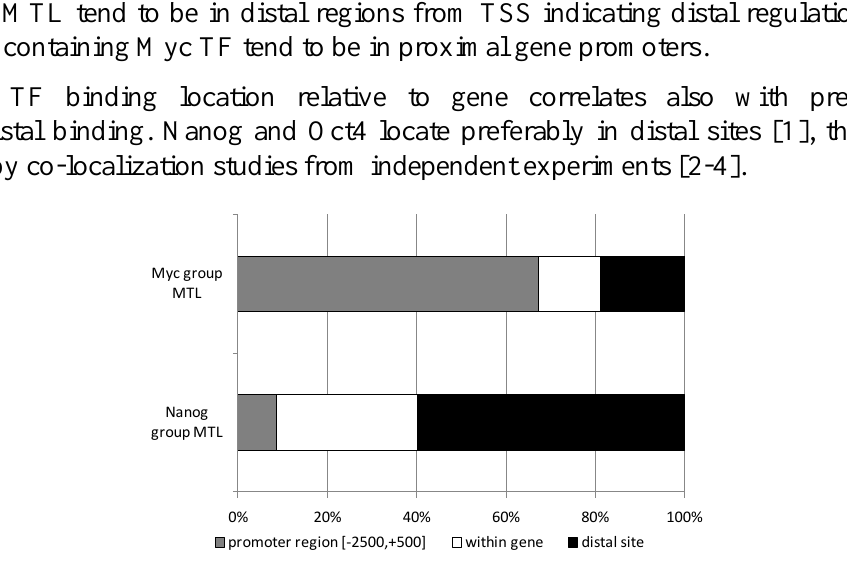
Figure 5: Pattern of promoter location of MTL depending on type of transcription factors in the cluster – Myc and Nanog